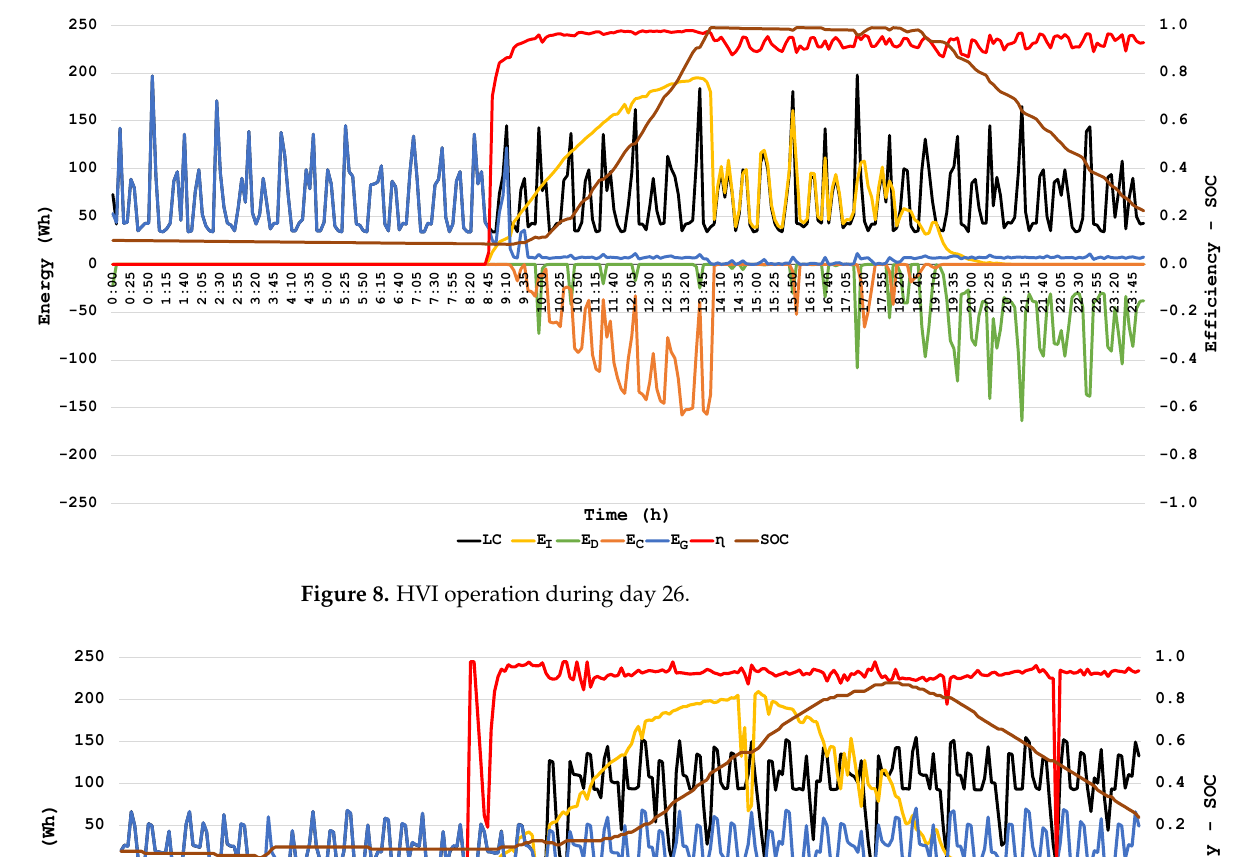
Figure 8. HVI operation during day 26.